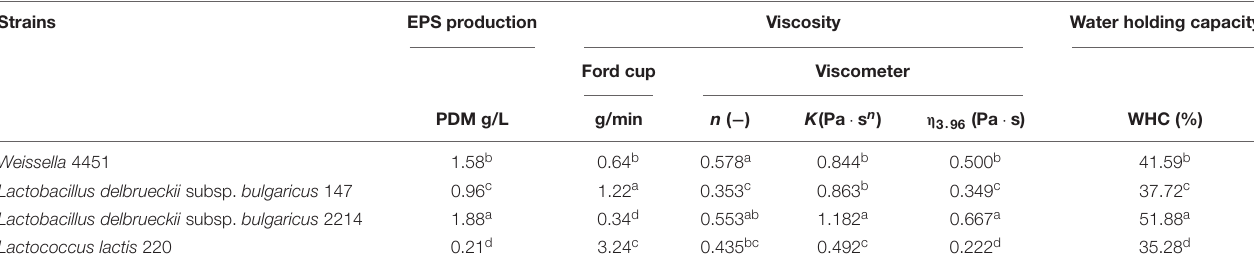
TABLE 2 | Exopolysaccharides production (PDM), viscosity (measured by mean of Ford cup and viscometer) and water holding capacity in milk fermented by EPS producers Weissella 4451 and Lactobacillus delbrueckii subsp. bulgaricus 147 and 2214 and negative control EPS- Lactococcus lactis 220. Strains EPS production Viscosity Water holding capacity